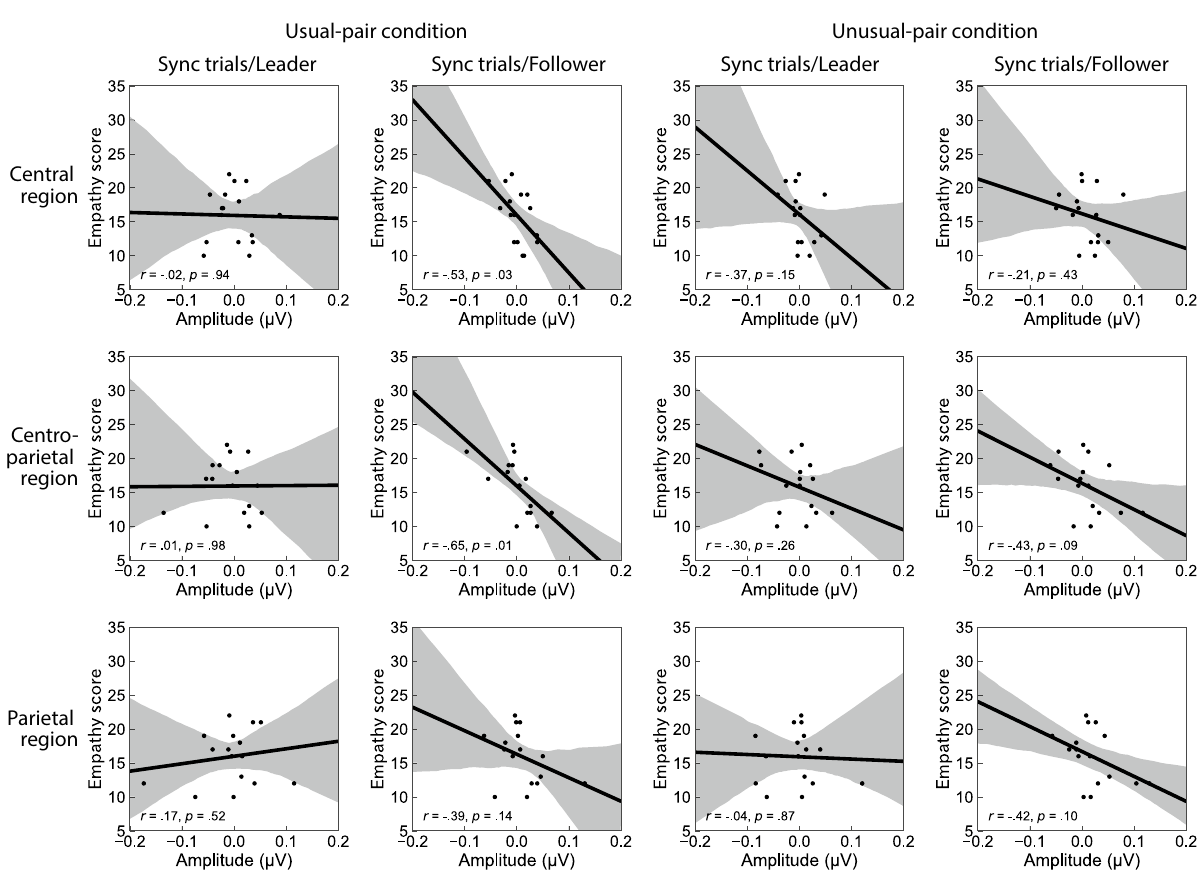
Figure 4. Correlations between changes in phi 2 (from control to sync trials) and EQS empathy scores in each condition. These scatter plots indicate the relation between the individual empathetic ability and the individual magnitude of the phi 2. Grey shaded areas represent 95% confidence intervals. EQS emotional intelligence participants synchronized their wrist movement as followers. The phi 2 correlated negatively with the empathy scores for the central and centro-parietal regions ( r = –0.53, p = 0.03, r = –0.65, p = 0.01, respectively), but not for